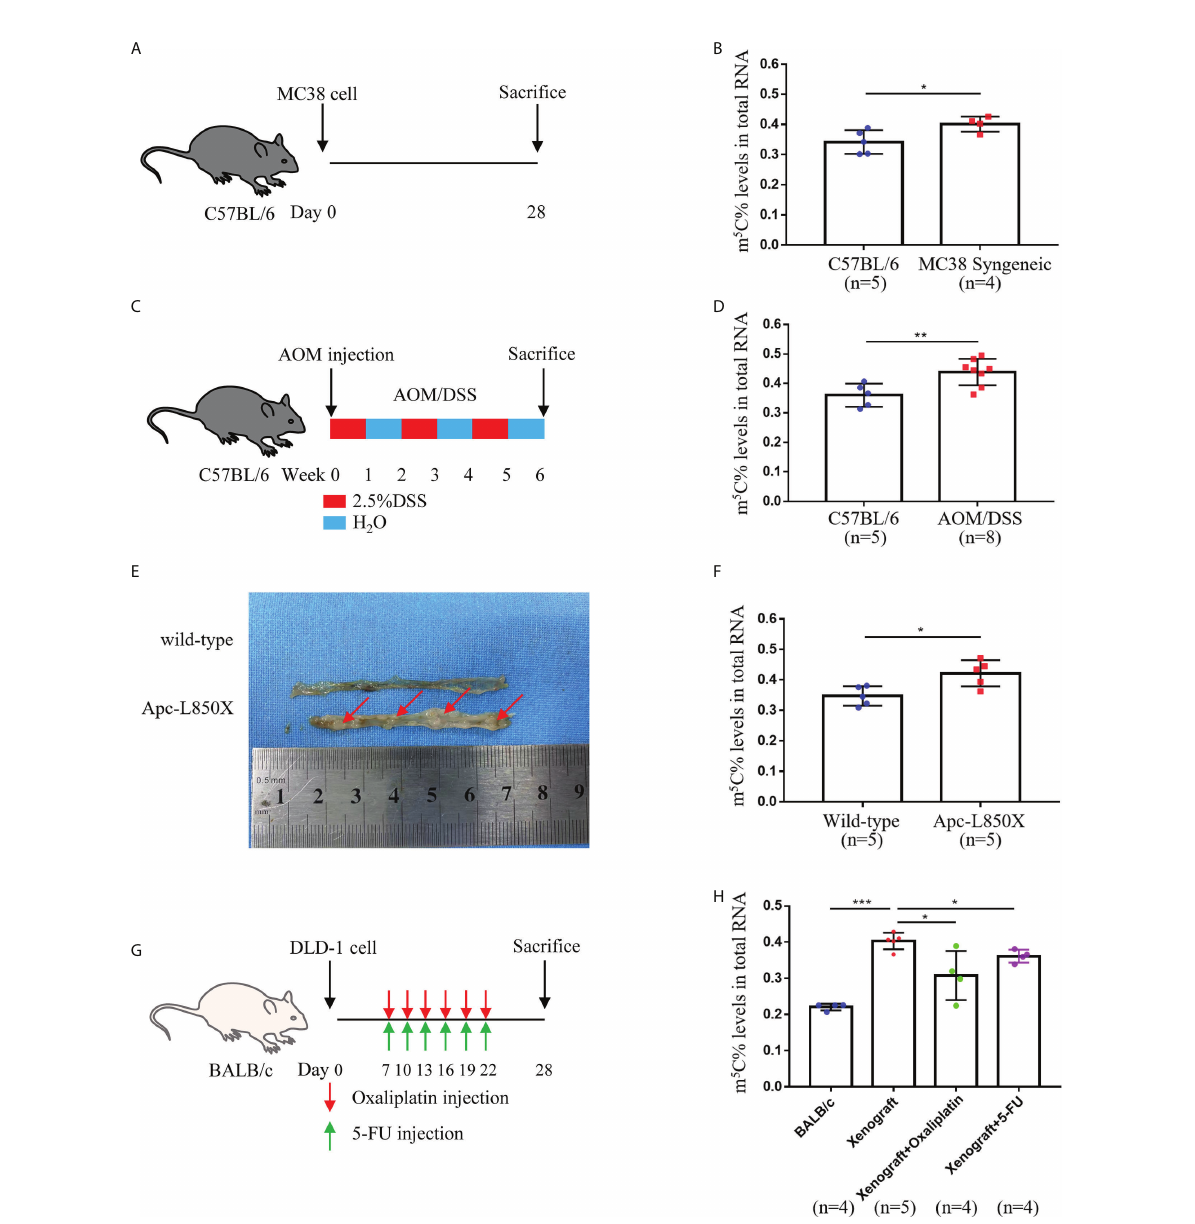
FIGURE 3 Levels of m 5 C in peripheral blood immune cells of CRC tumor-bearing mice. (A) Schematic representation of the MC38 Syngeneic CRC mouse model. (B) Comparison of m 5 C levels in blood immune cells between C57BL/6 controls and MC38 Syngeneic mice. (C) Schematic representation of the AOM/DSS CRC mouse model. (D) Comparison of m 5 C levels in blood immune cells between C57BL/6 controls and AOM/ DSS mice. (E) Representative tumor images of the colon in Apc-L850X mice were shown. (F) Comparison of m 5 C levels in blood immune cells between wild-type mice and Apc-L850X mice. (G) Schematic representation of the DLD-1 Xenograft CRC mouse model with Oxaliplatin or 5- FU treatment. (H) Comparison of m 5 C levels in blood immune cells between untreated and treated DLD-1 Xenograft mice. Data are shown as mean ± SD; * P < 0.05, ** P < 0.01, *** P <